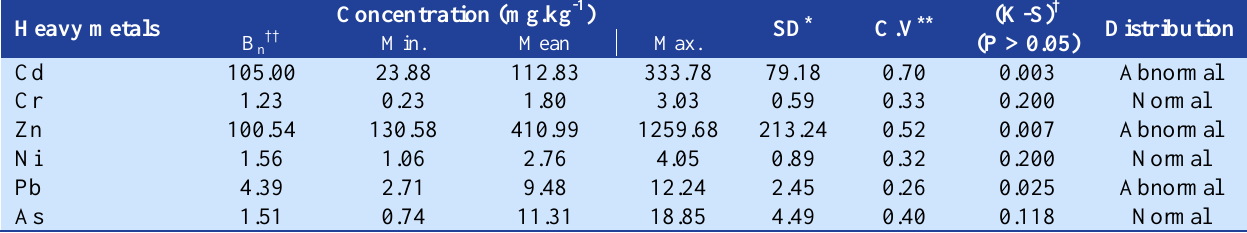
Correlation between roadside dust heavy metals Correlation measures the linear relationship between variables. The Pearson correlation coefficients and their significance levels between all of the variables are presented in table